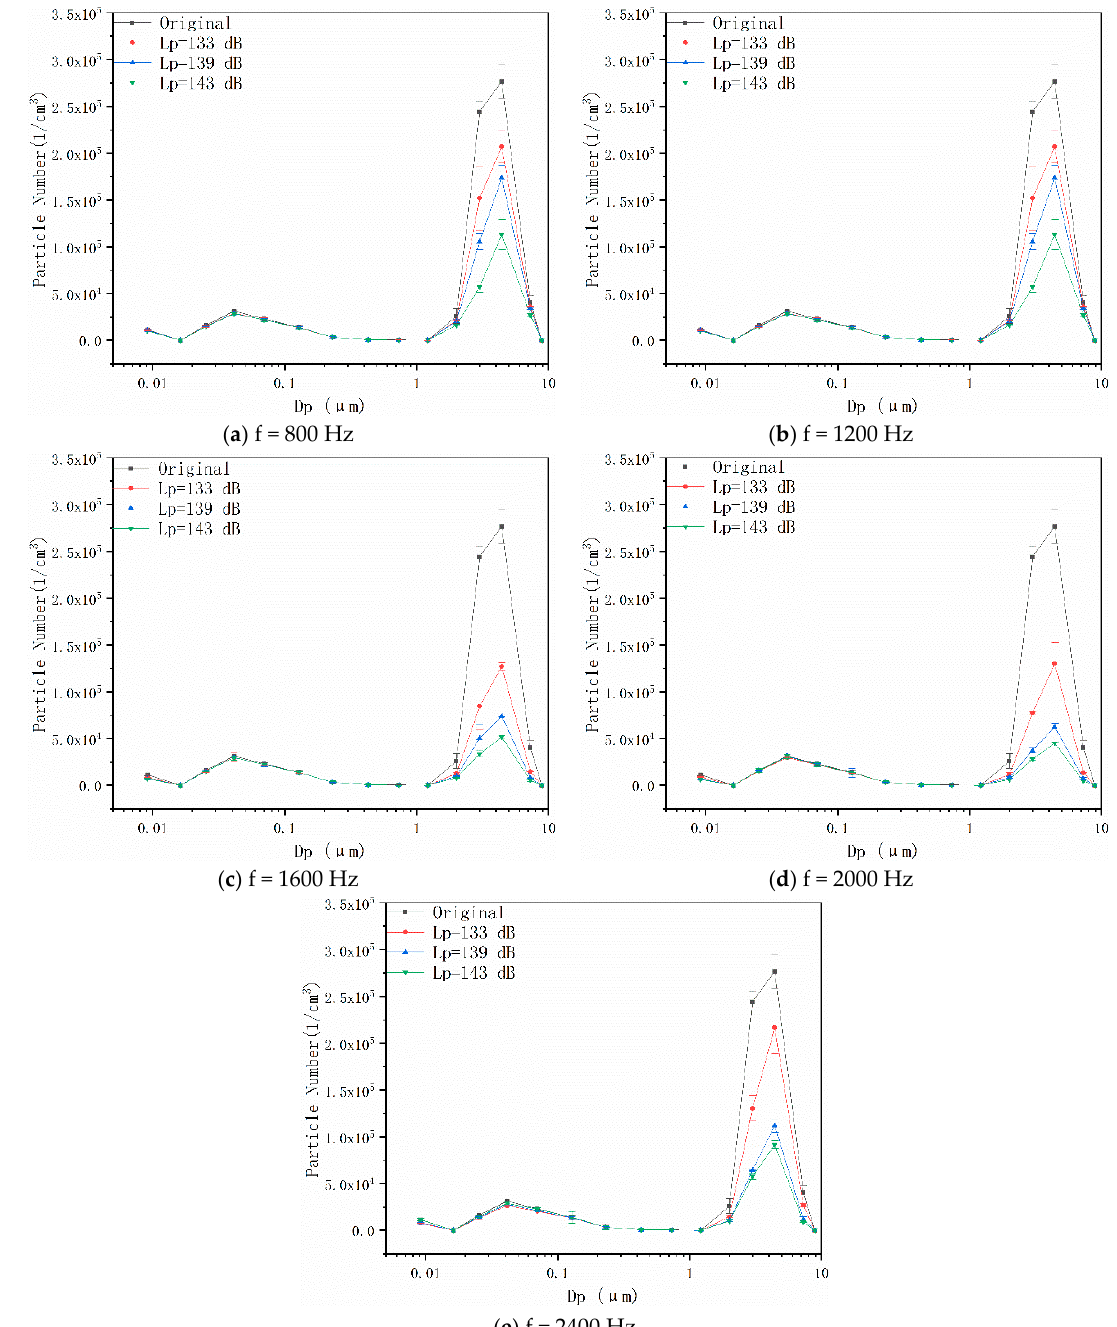
ff ect of SPLs on 4- µ m particles at di ff erent frequencies in acoustic agglomeration. Figure 7. Effect of SPLs on 4- μ m particles at different frequencies in acoustic agglomeration. Figure 7. E The reduction ratios of the 2- µ m particles at di ff erent acoustic frequencies and SPLs are shown in Figure